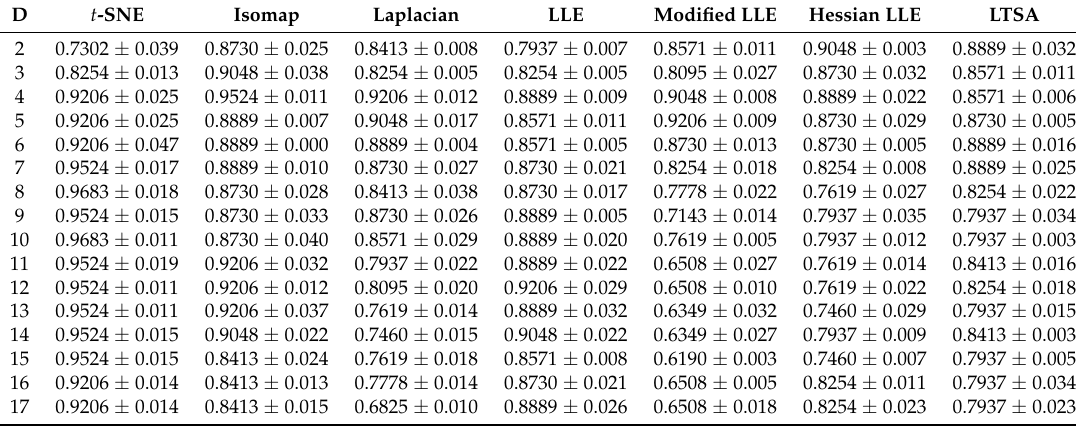
Table 6. Accuracy varying the dimensions with respect to the manifold learning algorithms. Data with MCGS